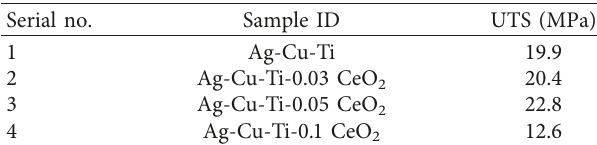
Figure 10: Shear stress-strain curves of the various Ag-Cu-Ti- x CeO 2 composites. Table 5: Shear strength data obtained from the shear stress-strain